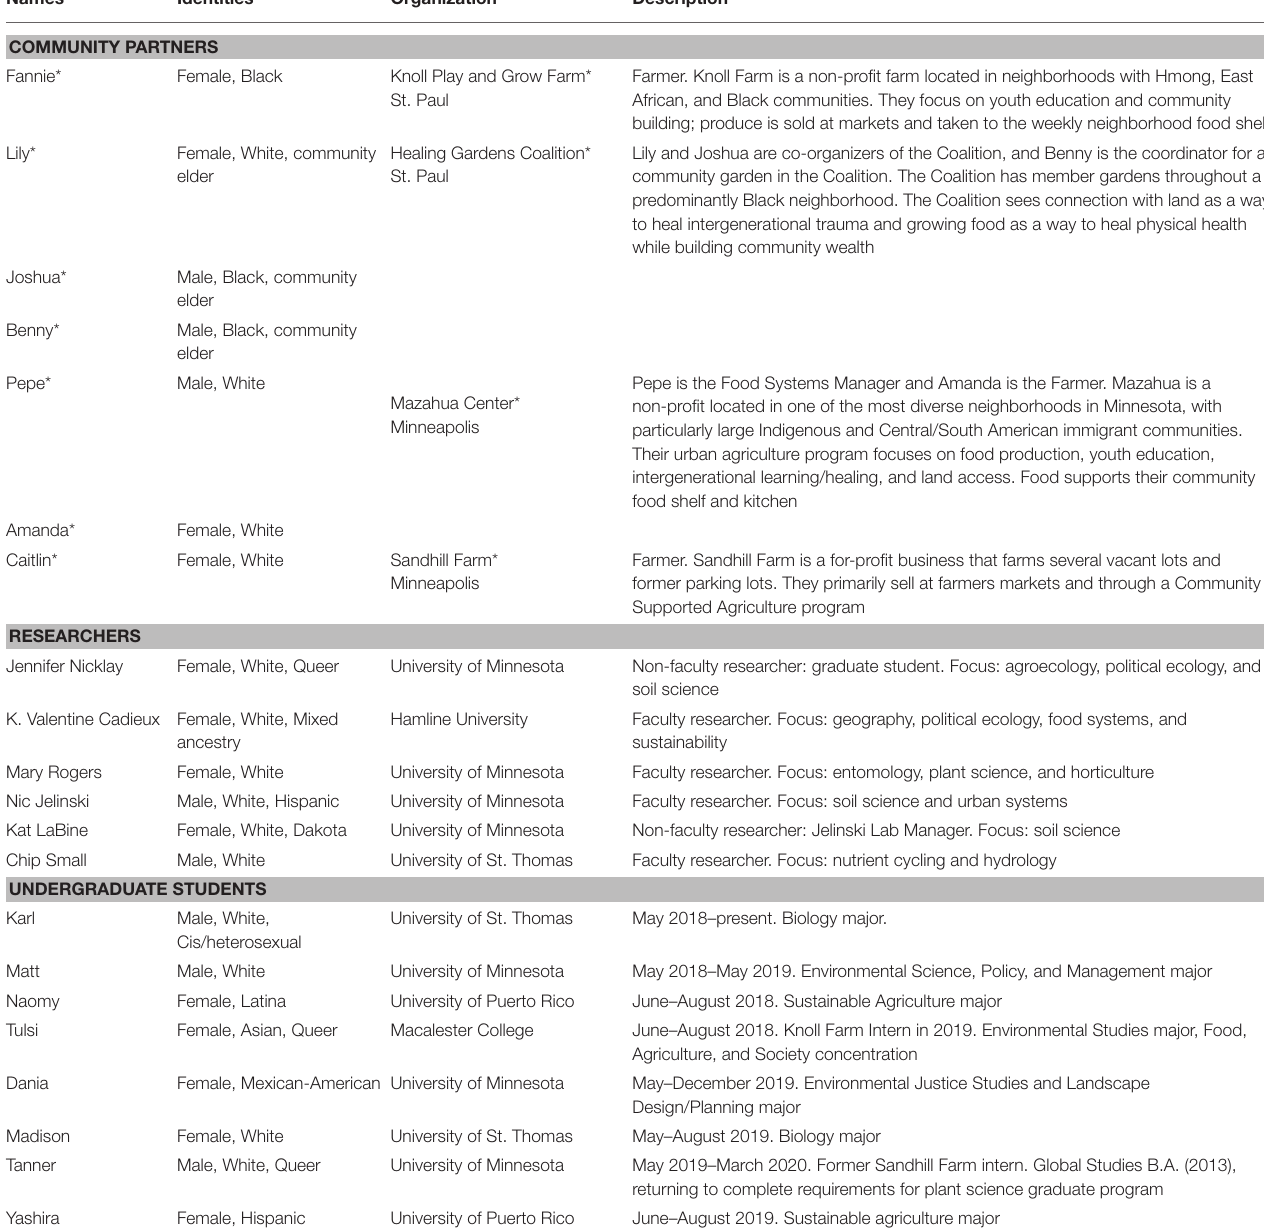
TABLE 2 | Fall 2019 Evaluation Respondents. Names Identities Organization